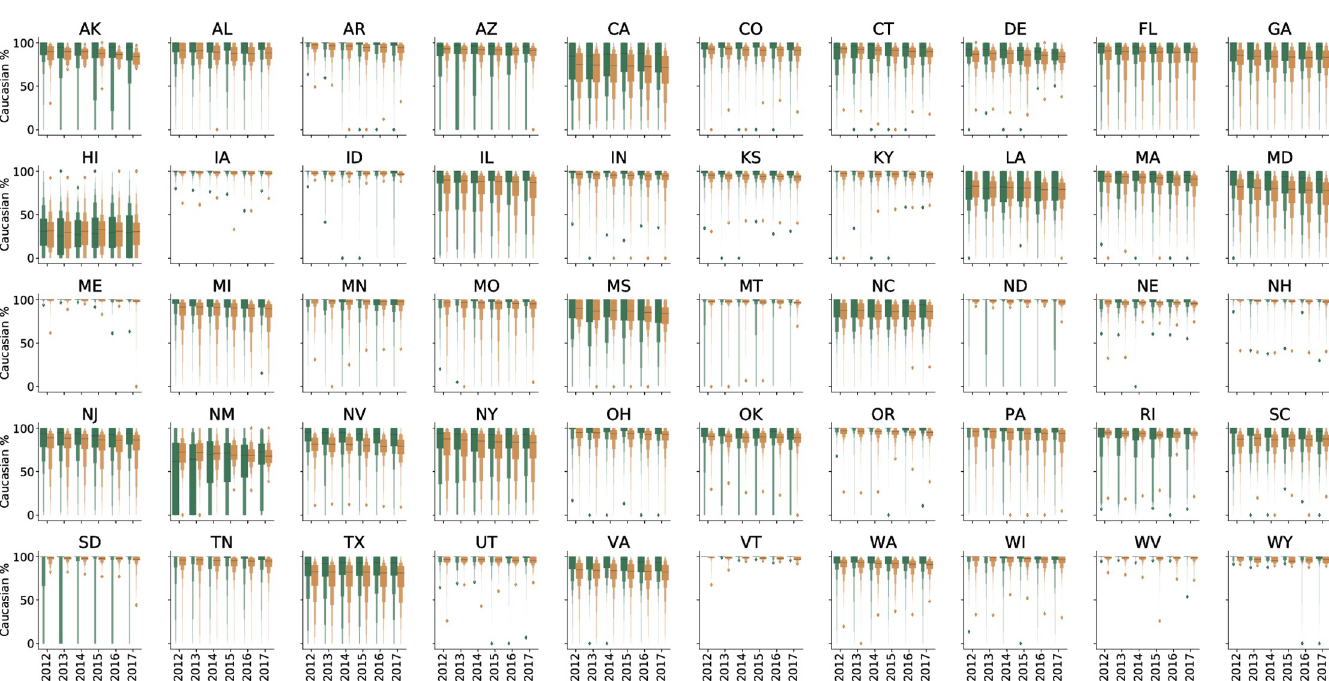
Fig 3. Letter-value plot for average percentage of Caucasian Medicare beneficiary population by state and eye provider type. Ophthalmologists are shown in yellow and optometrists are shown in green. The black line represents the median value.